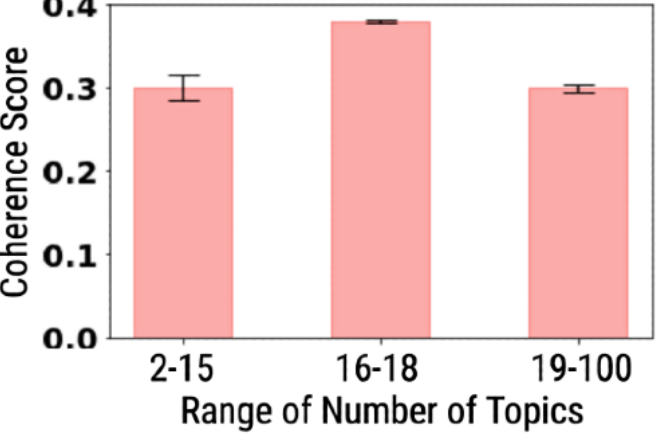
Figure 4. Coherence scores of latent Dirichlet allocation trained over pruned conversations (or reference summaries) over a number of topics. The topic coherence was measured using the formulation of CV